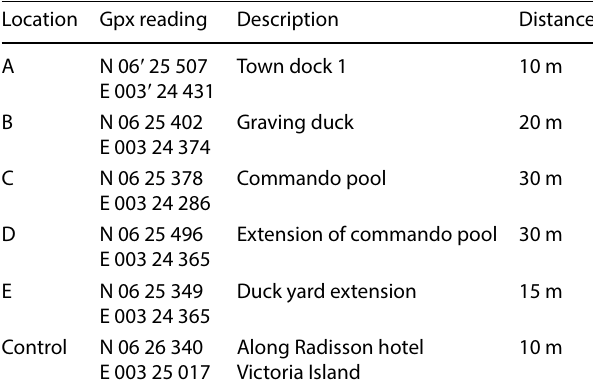
Table 1 Summary of the sampling points and their coordinates Location Gpx reading